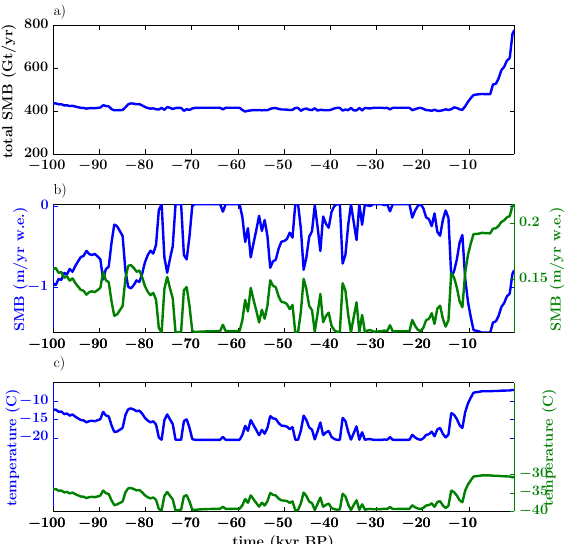
Figure 4. Time series of integrated GrIS SMB (a) . Marginal/summit specific SMB (b) : margin location is blue and the summit location is green; the vertical axes scaling is different for the two time se- ries to highlight the anticorrelated relationship between the two. Marginal/summit surface temperature (c) : margin location is blue and the summit location is green.